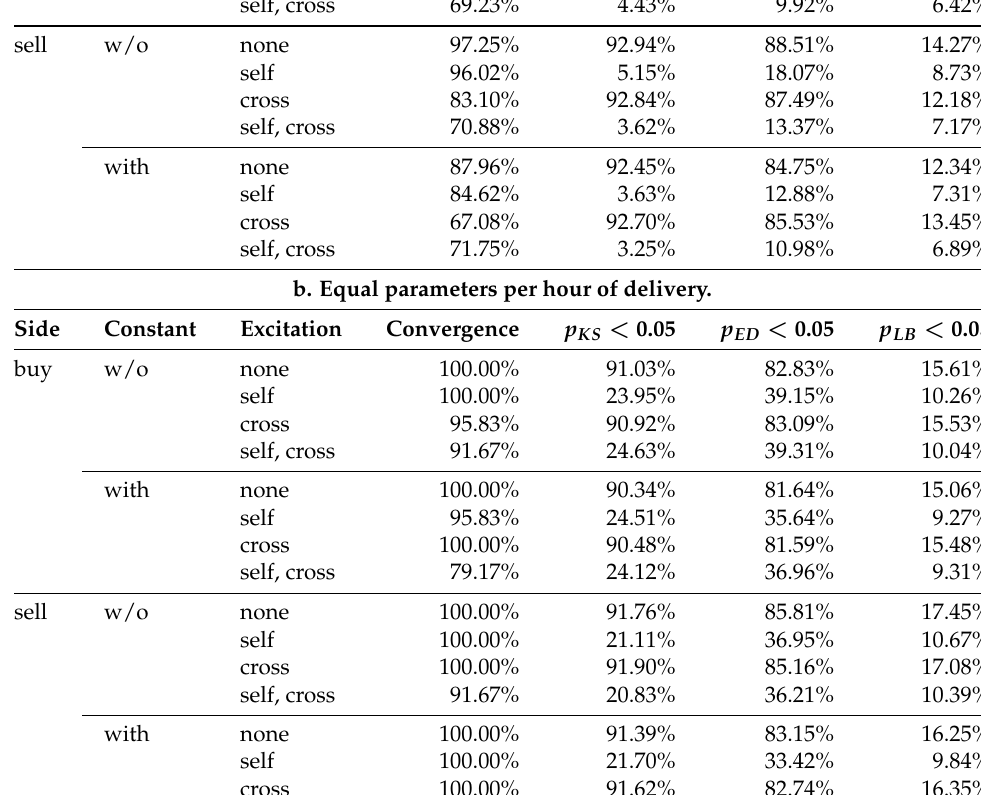
pooled transformed event times of the marginal processes. The frequencies of